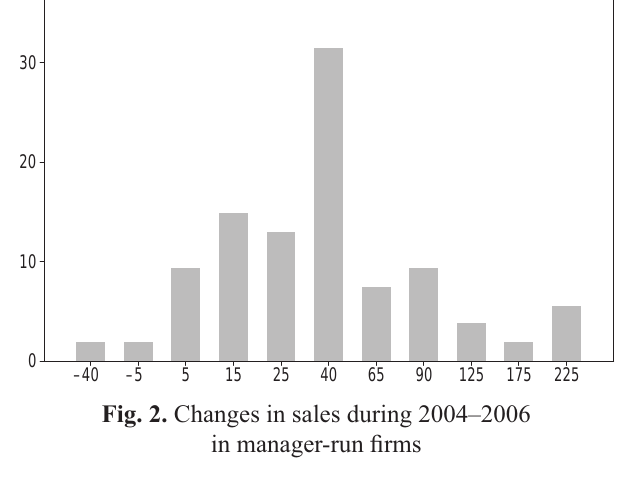
Fig. 2. Changes in sales during 2004–2006 in manager-run fi rms